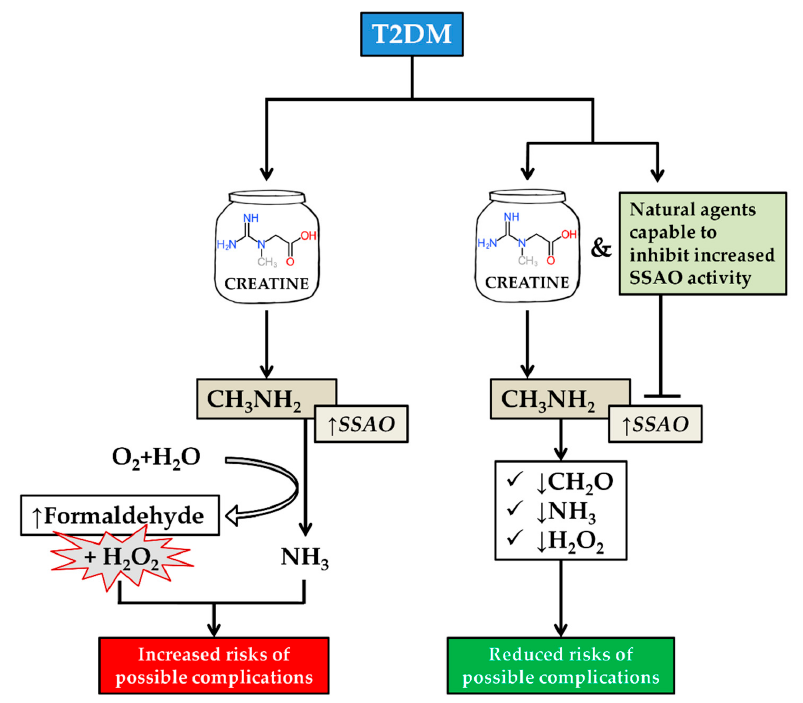
Figure 1. An illustration of the role of natural agents on SSAO activity throughout the supplementation of creatine in T2DM patients. Upregulation of SSAO activity and creatine related methylamine production which is a substrate of SSAO elevates formaldehyde, ammonia, and H 2 O 2 in T2DM patients which causes possible complications; Additional ingestion of natural agents capable to inhibit increased SSAO activity diminishes the production of formaldehyde, ammonia, and H 2 O 2 and risks of possible complications are reduced. Notes: T2DM, type 2 diabetes mellitus; SSAO, semicarbazide-sensitive amine oxidase; ↑ , upregulation; ↓ , downregulation; CH 3 NH 2 , methylamine; CH 2 O, formaldehyde; H 2 O 2 , hydrogen peroxide; NH 3 , ammonia.